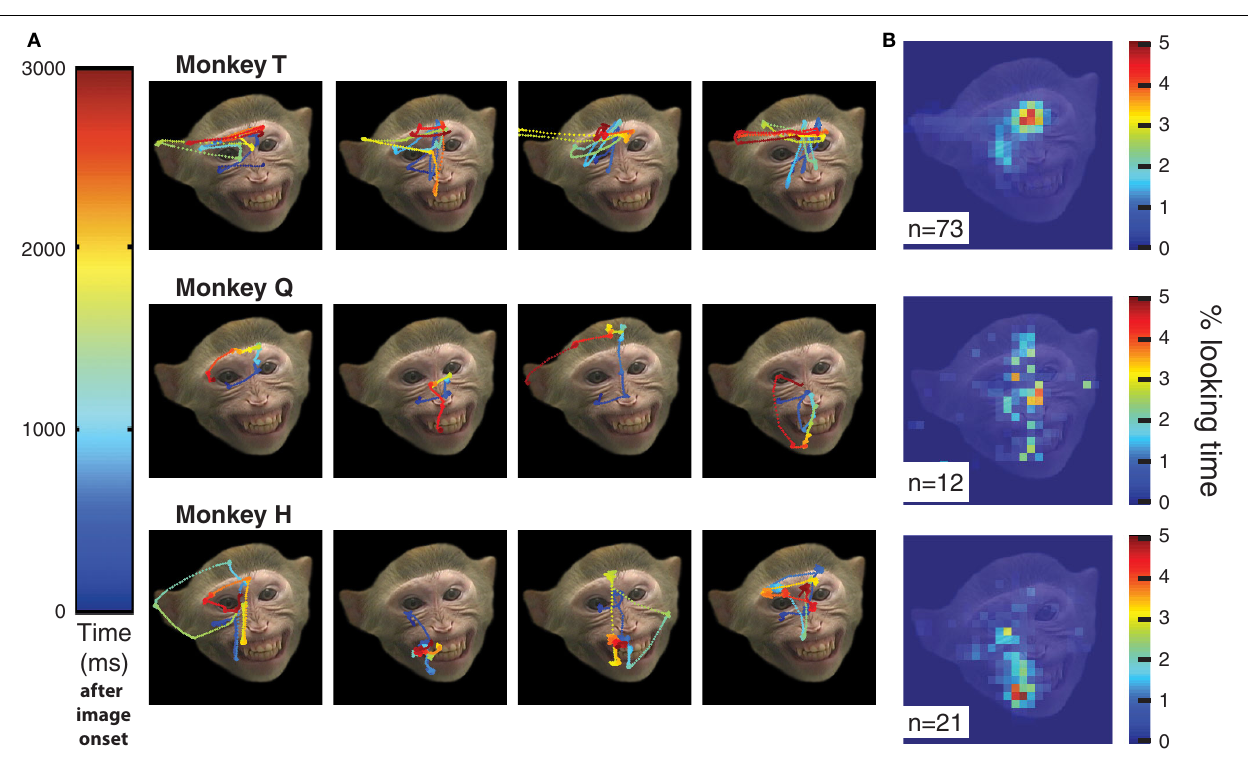
FIGURE 3 | Example scanpaths generated by the three subjects over the same image. (A) Eye position at each millisecond is represented by a line whose color indicates the time according to the color scheme on the left (blue is eye location at image onset and red is 3000 ms later, immediately before image removal). Note that monkey T looked at the eyes in the fi rst 500 ms, then at the mouth or midface around 1000 ms, and reliably visited the ear region toward the end of the scanning time. Monkey Q also preferred to look at the eyes, but spent